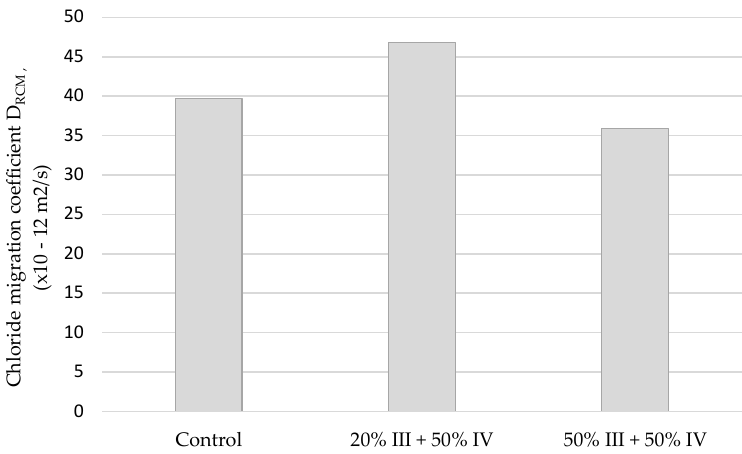
Figure 7. Results of resistance to chloride ion penetration. The recorded effective chloride migration coefficient D RCM for the control concrete showed a value of 39.7 × 10 − 12 cm 2 /m, while for the second (20% III + 50% IV) and third mixtures (50% III + 50% IV), D RCM was 46.8 × 10 − 12 cm 2 /m and 36.0 × 10 − 12 cm 2 /m, respectively. Freeze-thaw resistance of concrete in the presence of de-icing salts was tested according to EN 12390-9. After 28 cycles, mass loss of 0.132 mg/mm 2 and 0.181 mg/mm 2 were measured on concrete samples from the control and second (20% III + 50% IV) mixture, respectively. The third concrete mixture (50% III + 50% IV) had a significantly higher mass loss of 0.596 mg/mm 2 (Figure 8). Visual examination of all concrete mixtures showed different degrees of degradation of the concrete surface (Figure 9). The concrete mixture (50% III + 50% IV) showed not only superficial damage of the fine material, but also plucking of the coarse aggregate grains (Figure 9c).